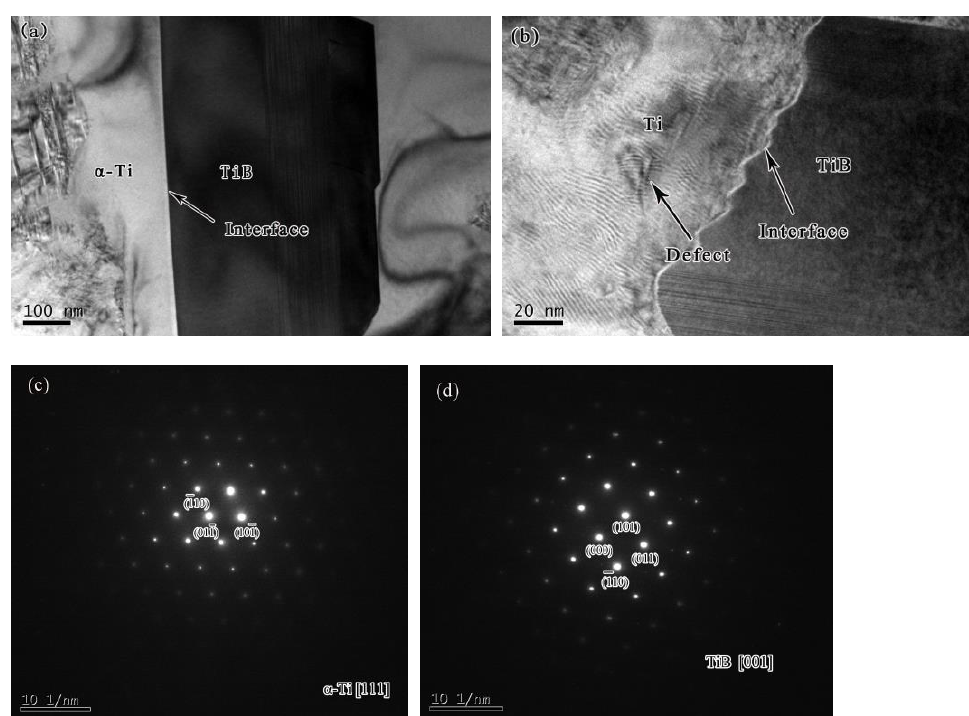
Figure 7. Interface and matrix defects of two different morphologies of TiB and α -Ti: ( a ) TiB and Ti matrix with long strip-like structures; ( b ) TiB and Ti matrix with granular structures of Figure b; ( c ) α -Ti diffraction spot; ( d ) TiB diffraction spot of Figure b.